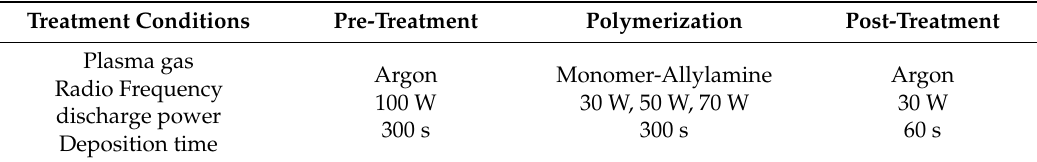
Table 1. Process conditions for amine